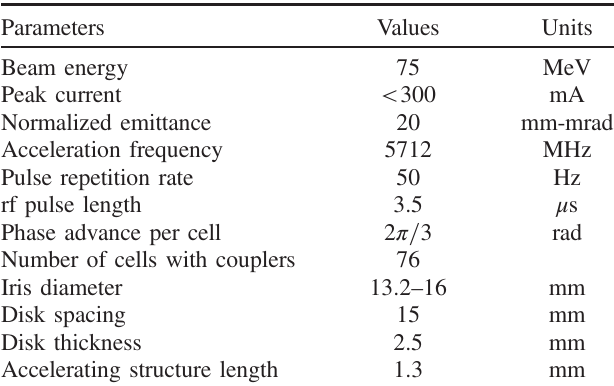
FIG. 2. Number of emitted neutrons dependence of electrons energy dumped at lead